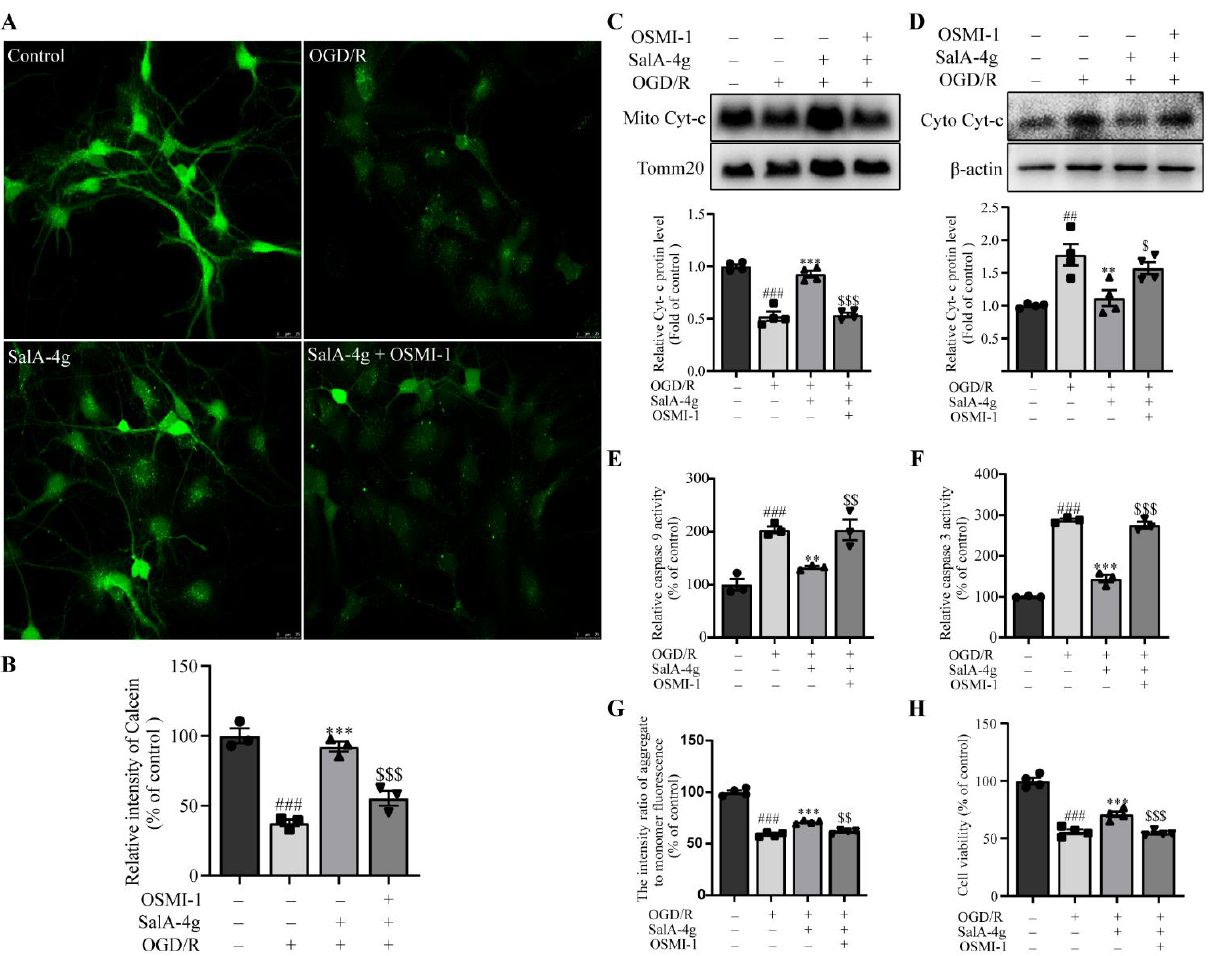
Figure 8. O-GlcNAcylation on mitochondrial proteins is involved in SalA-4g regulation of mitochondrial apoptosis path- way and neuronal survival in cortical neurons under OGD/R stress. ( A , B ) Representative fluorescence images ( A ) and quantification of average fluorescence intensity ( B ) of calcein in the control, OGD/R alone, OGD/R + SalA-4g, OGD/R +